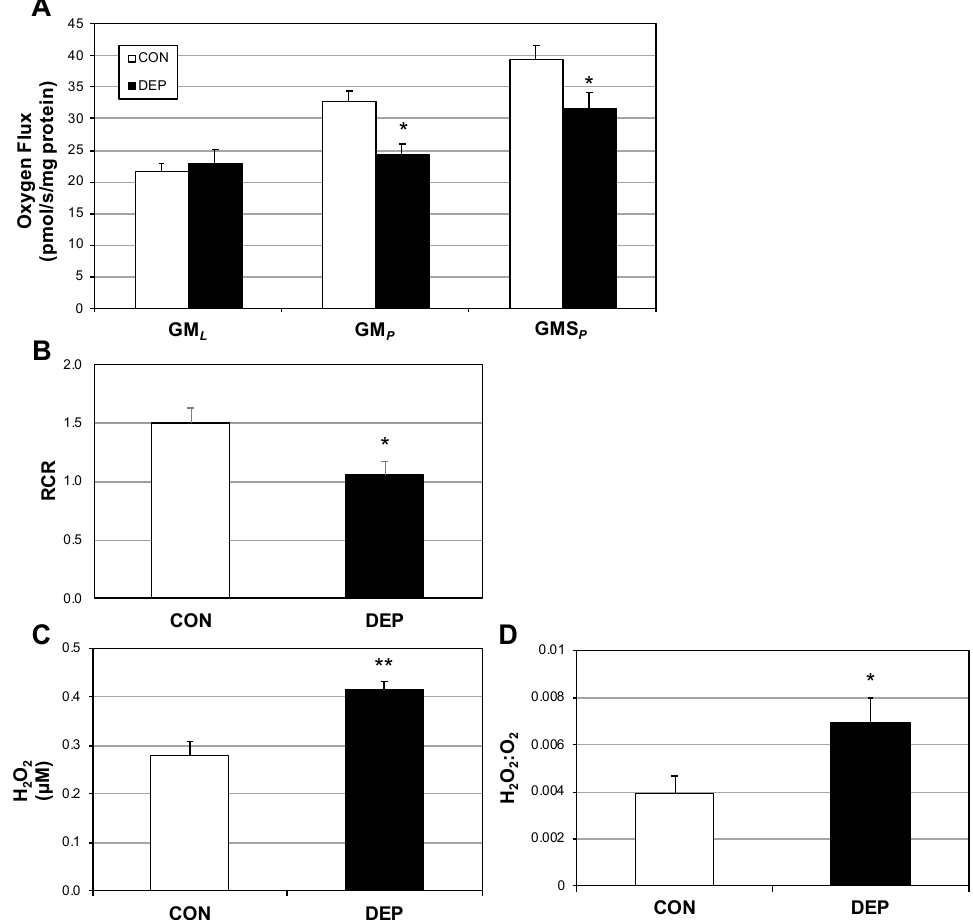
Figure 1. Diesel exhaust particle exposure deleteriously alters alveolar macrophage mitochondrial function in mice. Following 4 weeks of room air (CON) or diesel exposure (DEP), alveolar macrophages were obtained from mice and mitochondrial respiration ( A ) and respiratory control ratio (RCR) ( B ) were quantified. O 2 consumption was determined according to the protocol outlined in materials and methods. GM L : glutamate (10 mM) + malate (2 mM); GM P : +ADP (2.5 mM); GMS P : +succinate (10 mM); and +antimycin A (2.5 μ M; not shown) as baseline. Furthermore, H 2 O 2 levels ( C ) and the H 2 O 2 :O 2 ratio ( D ) were measured. n = 8. * p < 0.05, ** p < 0.01; CON vs. DEP.